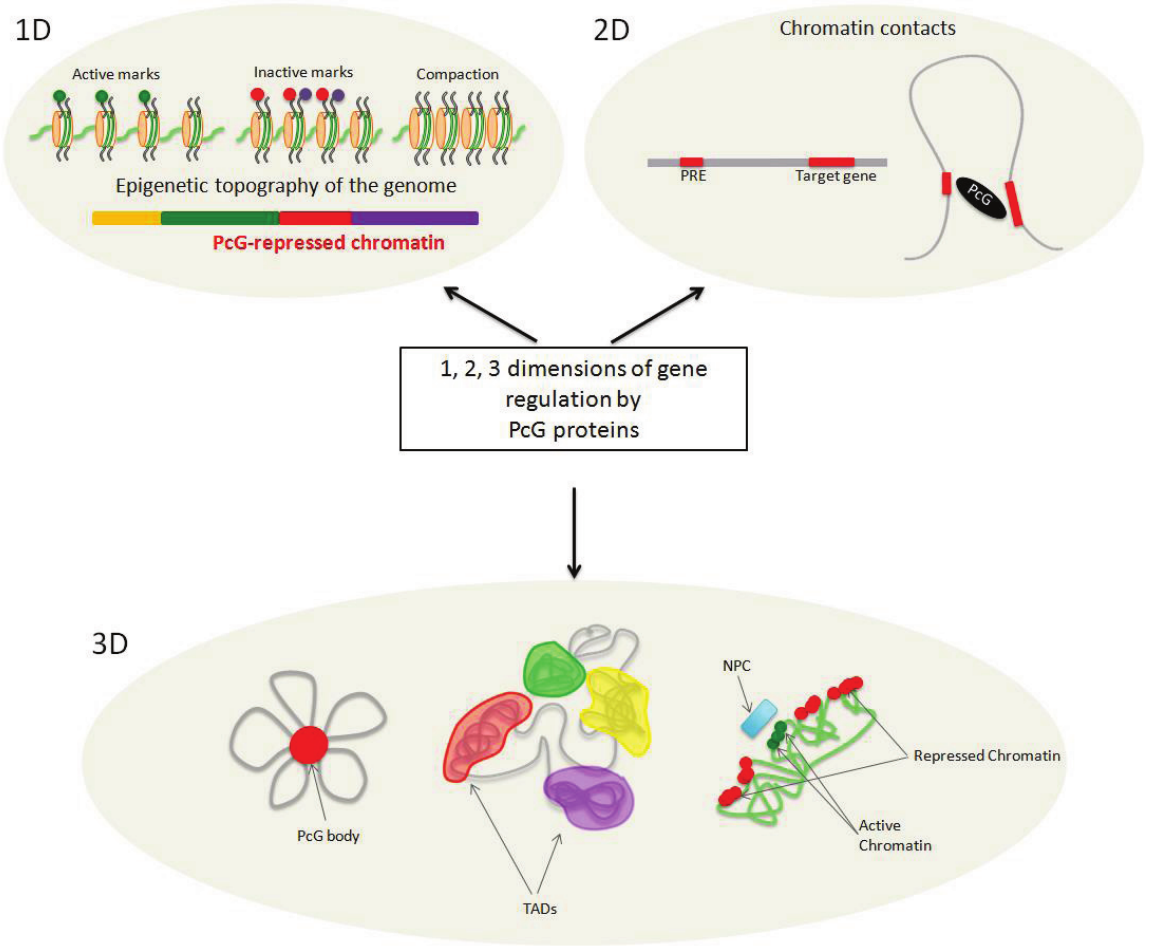
Figure 1. Polycomb Group (PcG) proteins affect chromatin regulation in three